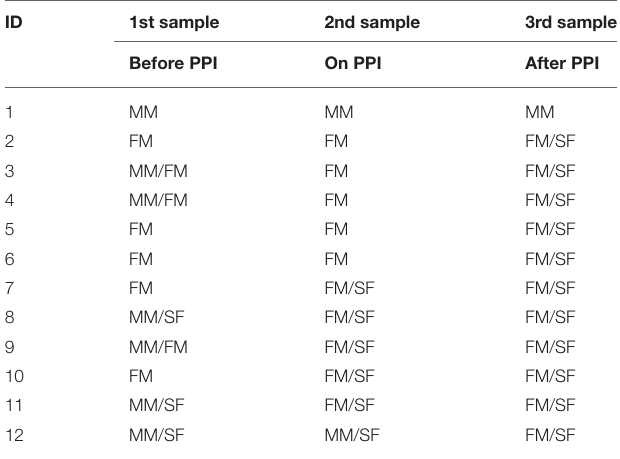
TABLE 1 | Results of the 24 h-pH-MII before initiation of oral PPI therapy ( n = 12). AET ABET WABET NABET TBET NRA NRWA NRNA NRT